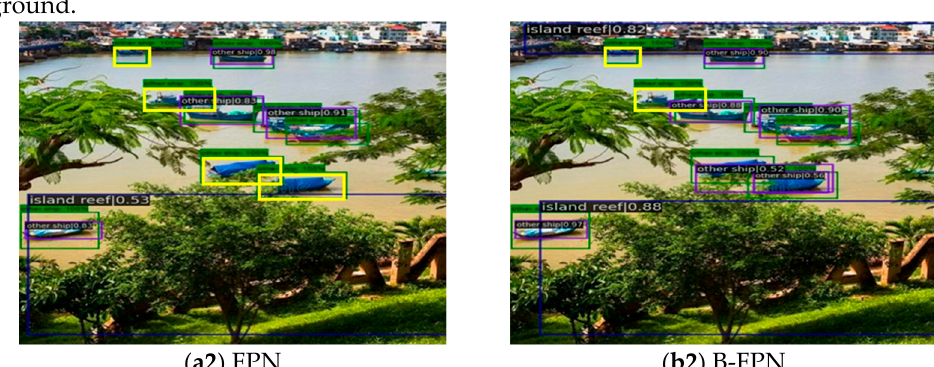
Figure 11. Comparison of FPN and B-FPN detection results (Green box is real target box and yellow box is missed ship target).